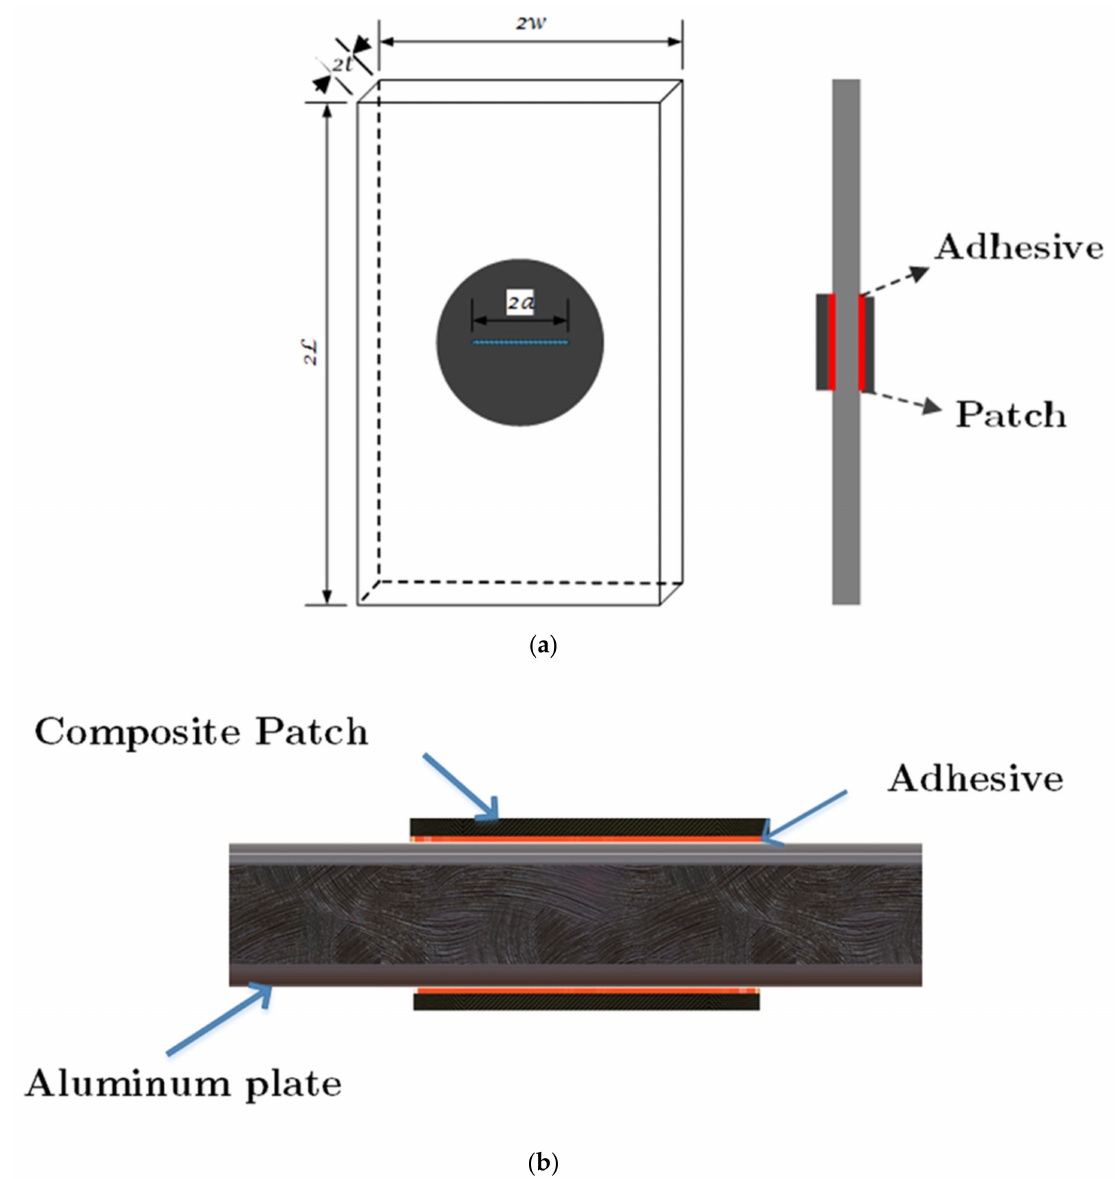
Figure 1. Geometry of repaired damaged aluminum plate: ( a ) Perspective view and ( b ) Front